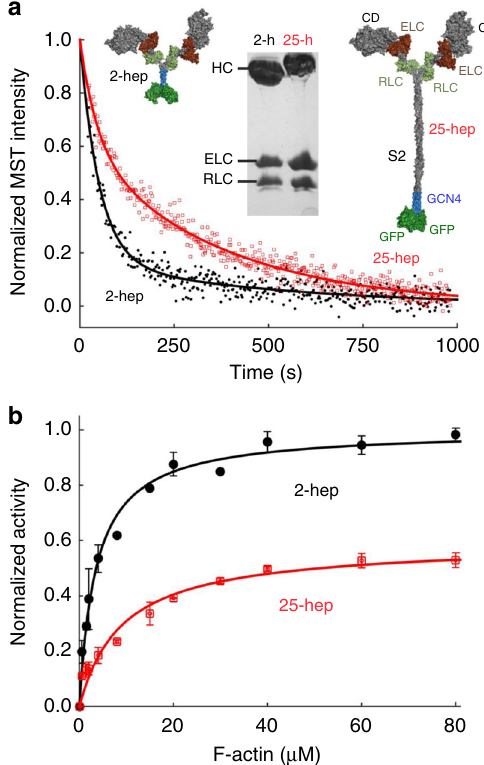
Fig. 3 WT 25-hep HMM has lower ATPase activity than WT 2-hep HMM. a Mant-ATP single turnover kinetics of WT 2-hep HMM (black solid line and fi lled circles) and 25-hep HMM (red solid line and empty squares). Representative data from one preparation of each protein. Data is fi t to a double exponential [Eq. (1)), with the slow phase in the 25-hep HMM clearly visible. Inset shows models of the 2-hep and 25-hep HMM, along with an SDS-PAGE gel showing the human heavy chain, the human ELC and the human RLC for both the 2-hep and 25-hep HMM (for uncropped image, see Supplementary Fig. 4). b Actin-activated ATPase activity of WT 2-hep HMM (black solid line and fi lled circles) and WT 25-hep HMM (red solid line and empty squares). Data is combined from two independent protein preparations with two experimental replicates for each preparation. Each point is an average with the error bar representing the SEM. Source data are provided as a Source Data fi